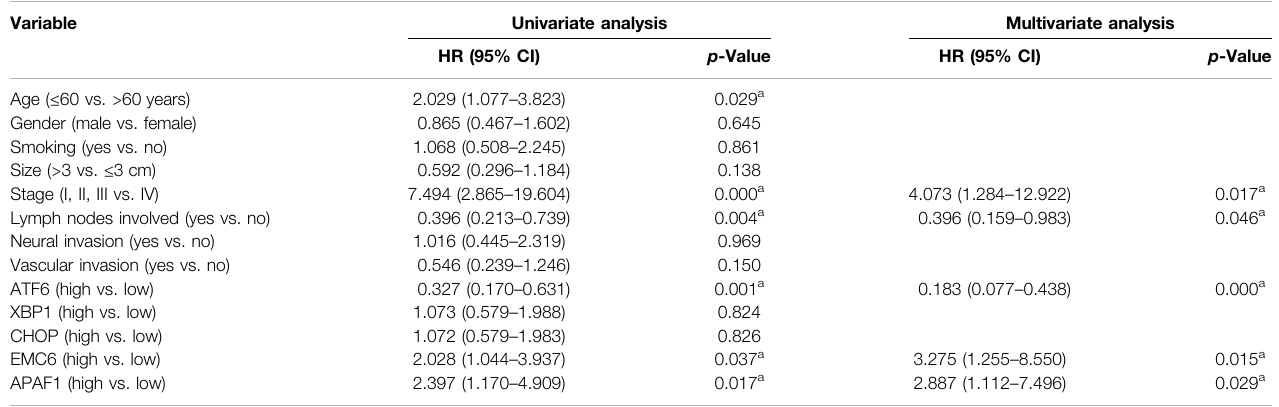
TABLE 4 | Univariate and multivariate Cox regression analysis for disease-speci fi c survival.